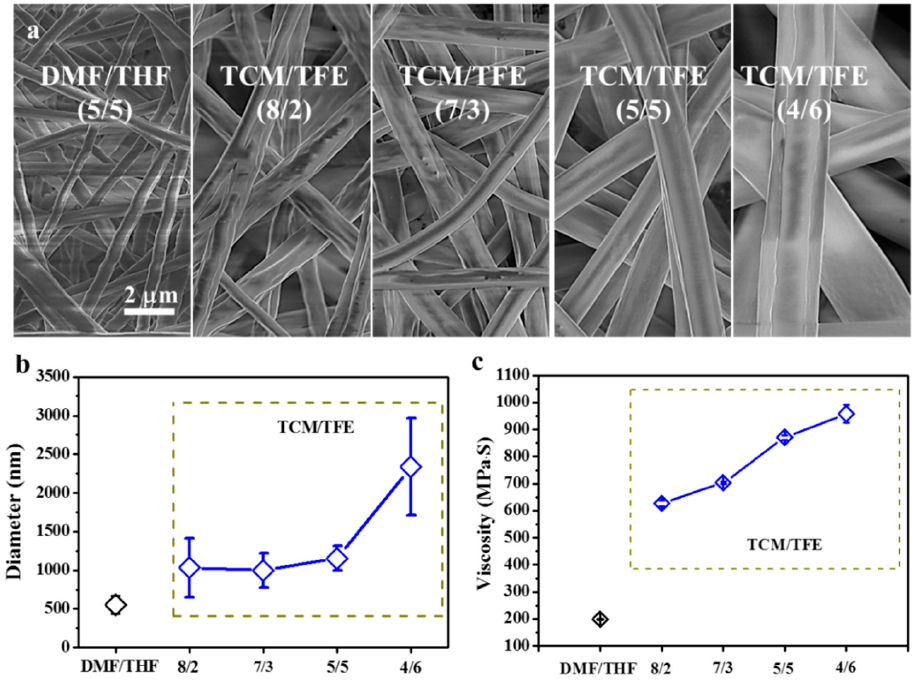
Figure 3. ( a ) SEM images and ( b ) diameters of electrospun TPU nanofibers from DMF / THF and TCM / TFE solvent systems; ( c ) viscosities of TPU in DMF / THF and TCM / TFE solvent systems (8% w / v ).